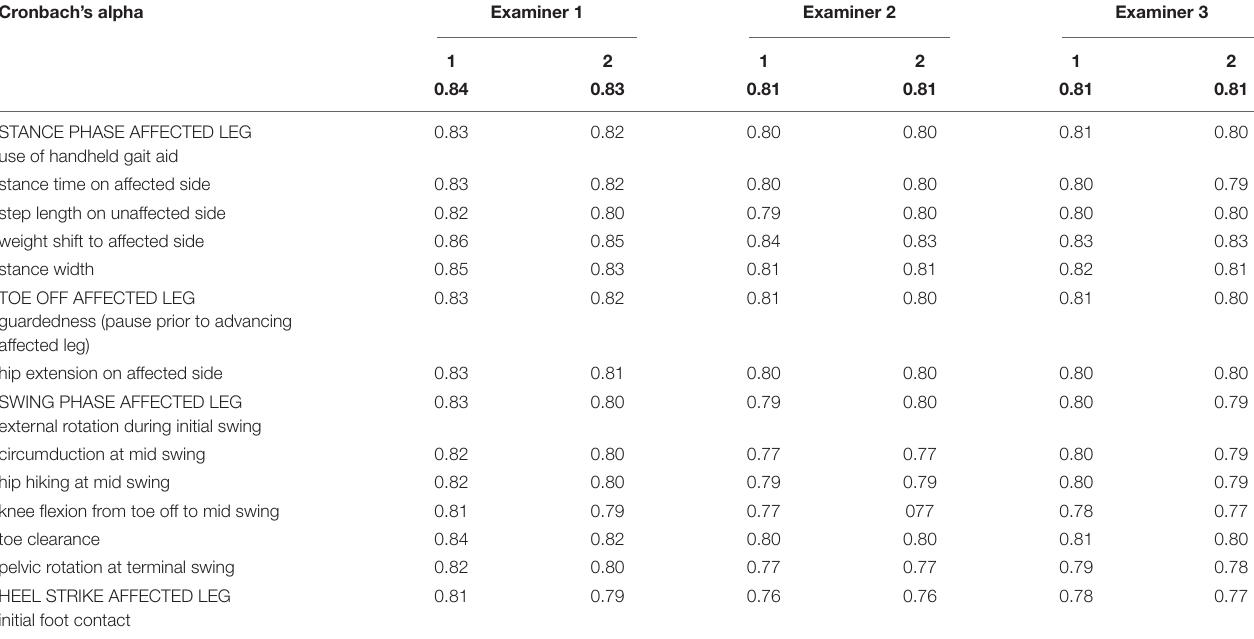
TABLE 3 | Agreement between measurements 1 and 2 performed by examiners 1,2 and